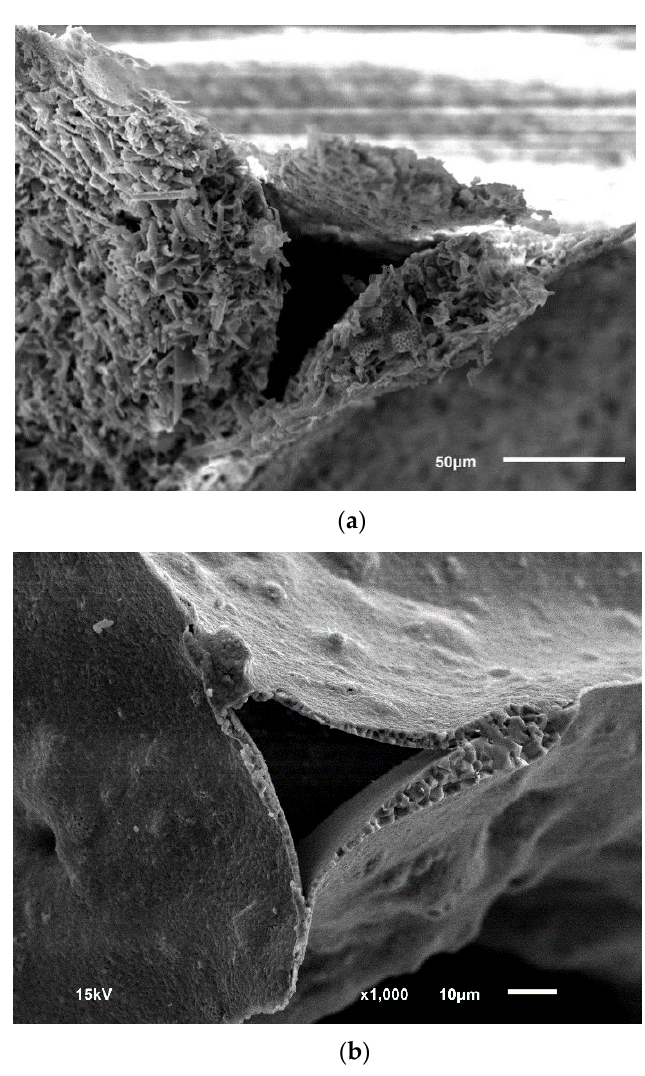
Figure 4. SEM images of a fractured strut wall of a ( a ) reticulated porous diatomite-kaolin composite specimen and ( b ) reticulated porous alumina with a pore density of 10 PPI.